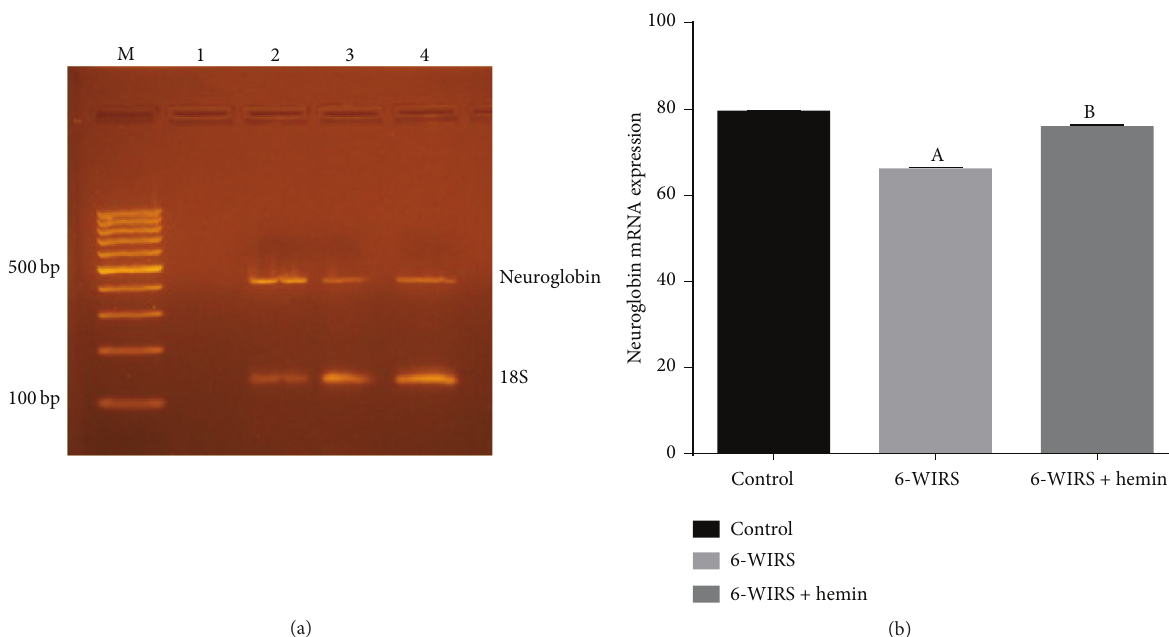
Figure 2: Effect of 6-hour water immersion restraint stress (WIRS) with or without hemin on neuroglobin mRNA expression in brain. (a) M: 100bp ladder. Lane 1: negative control, lane 2: control group, lane 3: WIRS group, and lane 4: hemin-treated group. (b) A Significant difference from the control group and B significant difference from the WIRS group, 𝑝 ≤ 0.05. Values are expressed as mean ± SEM of 10 rats in each group.